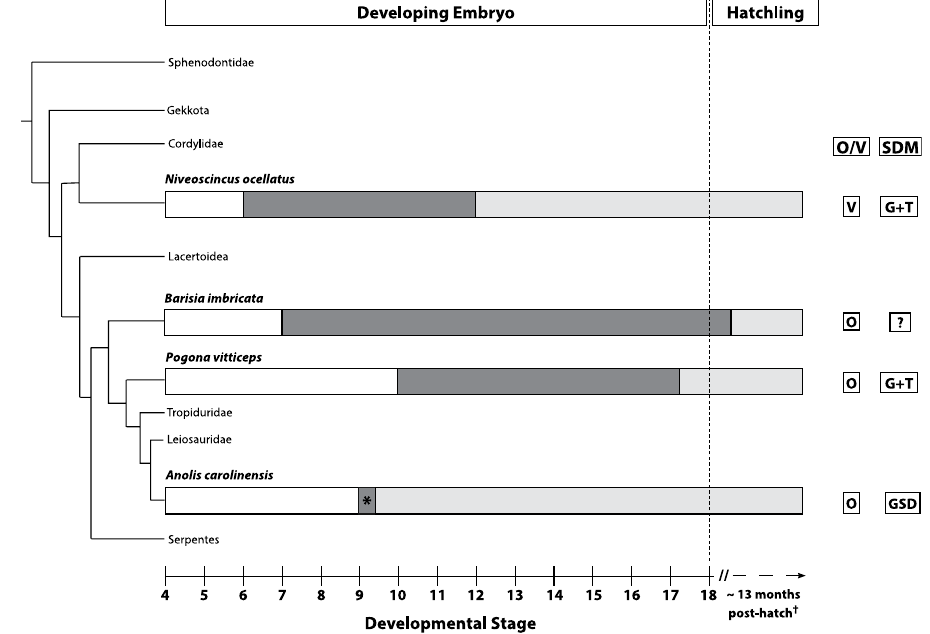
Figure 1. The timing and duration of temporary pseudohermaphroditism (TPH) in squamates. White bars indicate indeterminate sex, dark grey shows the TPH phase, and light grey indicates dimorphic sexes. The asterisk symbol for Anolis carolinensis indicates that there is a short delay (half a stage) between ovarian differentiation and genital dimorphism but is functionally lacking TPH. The dagger symbol on the dotted section of developmental stage axis indicates the approximate post-hatch timing of hemipenis regression in Barisia imbricata 31 . The timing of events are approximations standardised to the staging system described for Pogona vitticeps 27 . The reproductive mode (O/V) and sex determination mode (SDM) is reported for each species (O = oviparity, V = viviparity, G + T = genetic with thermal influence, GSD = genetic sex determination). The dashed vertical line at stage 18 denotes approximate time of hatching/birth. Phylogeny adapted from 70 , branch length is for illustrative purposes